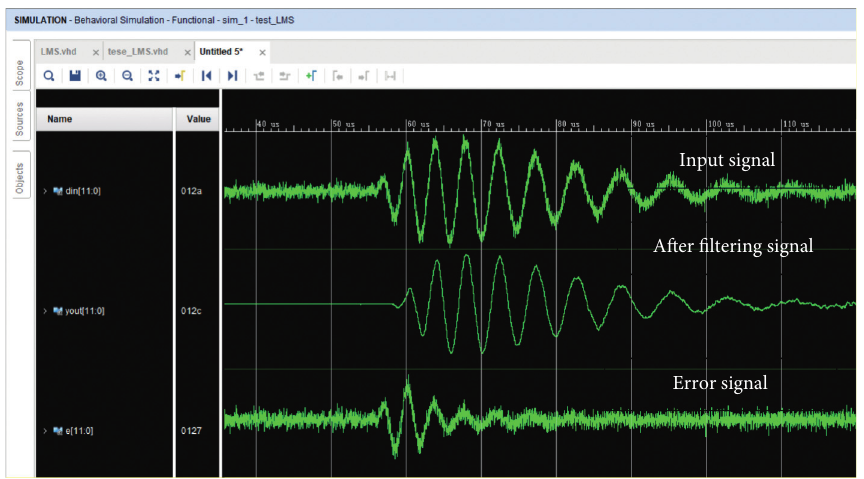
Figure 15: Denoising simulation results of the filter hardware.